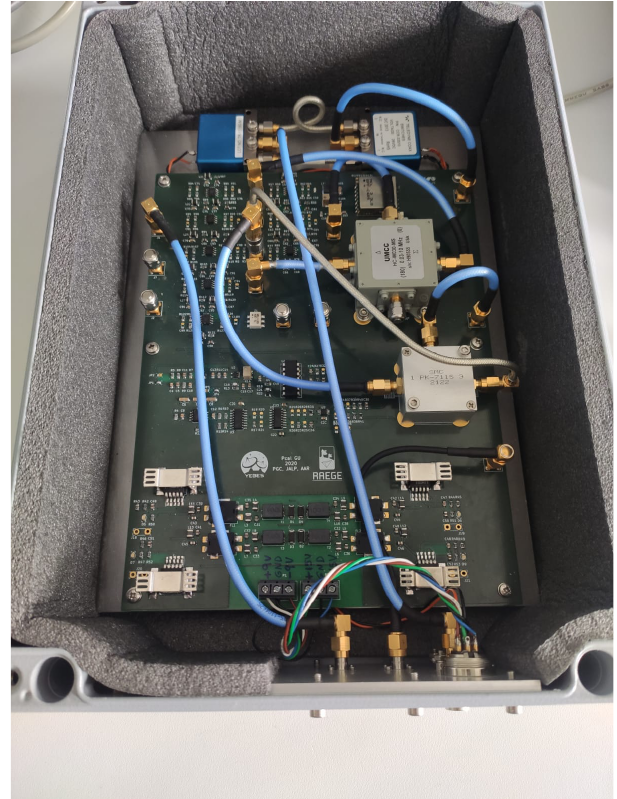
Figure 5. Internal view of phaseCal GU.